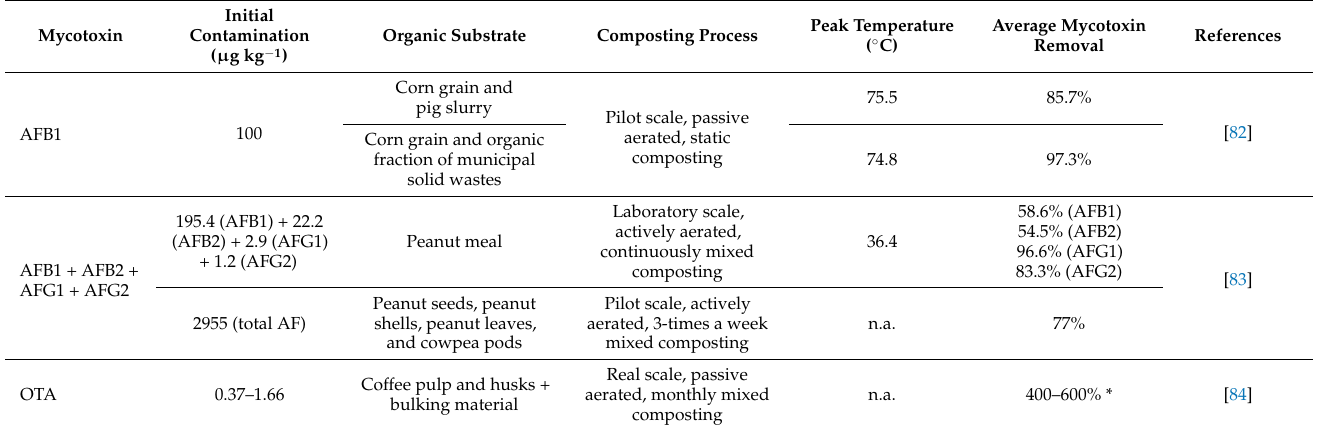
Table 5. Composting of mycotoxin-contaminated products: process characteristics and mycotox- ins’